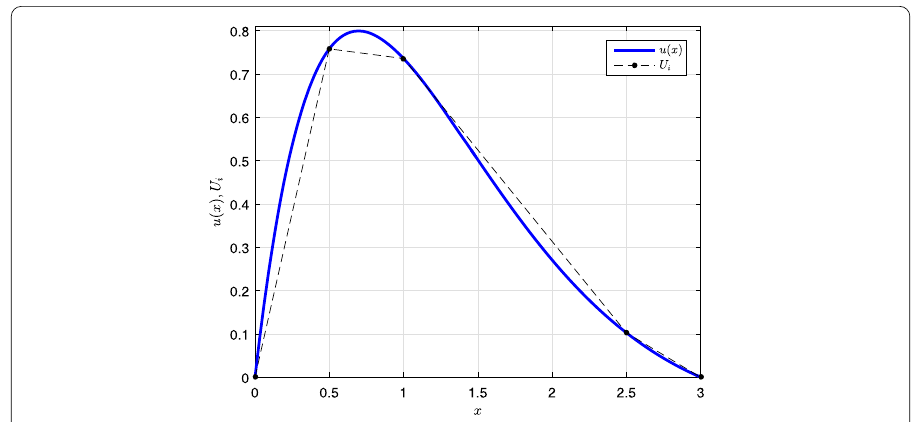
Figure 3 Solution of the example of the Dirichlet problem Graph of the solution u ( x ) for problem (Example 4.1) (solid line) and the discretized solution to the system of linear equations LU = F D (dotted